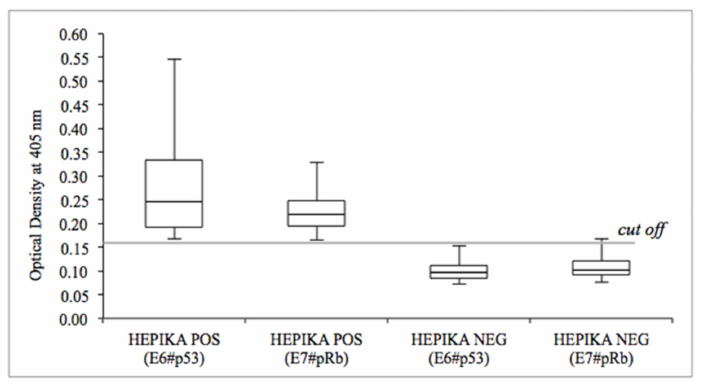
Figure 6. Distribution of complexes E6#p53 and E7#pRb optical density in relation to Hepika test result. Data are presented in boxes and whiskers’ style, which represents the medians and ranges of the data. (Abbreviations: POS: positive; NEG: